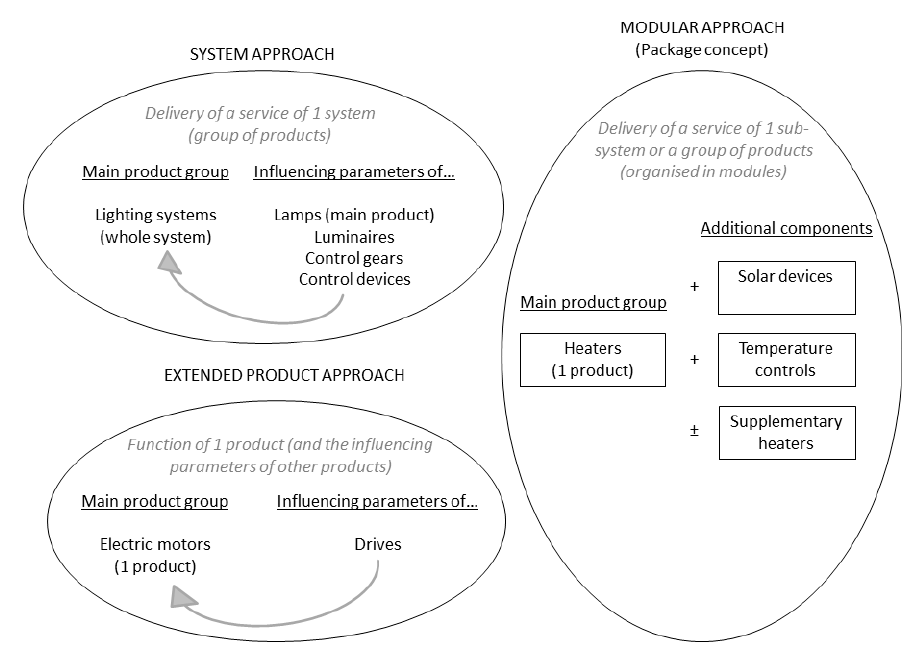
Figure 2. Differences between the calculation methods of the extended product, system and modular approaches (with examples).